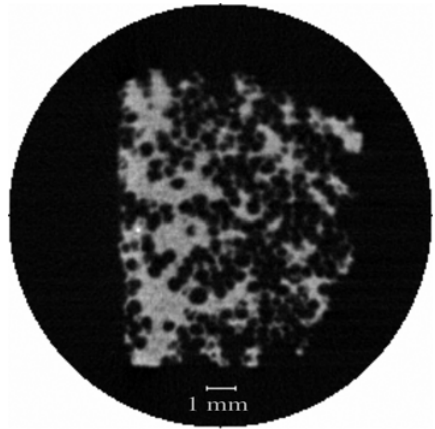
Figure 3. CT image of 60 ppi ceramic sample (9 × 11mm 2 ) meas- ured at 28.3 keV.